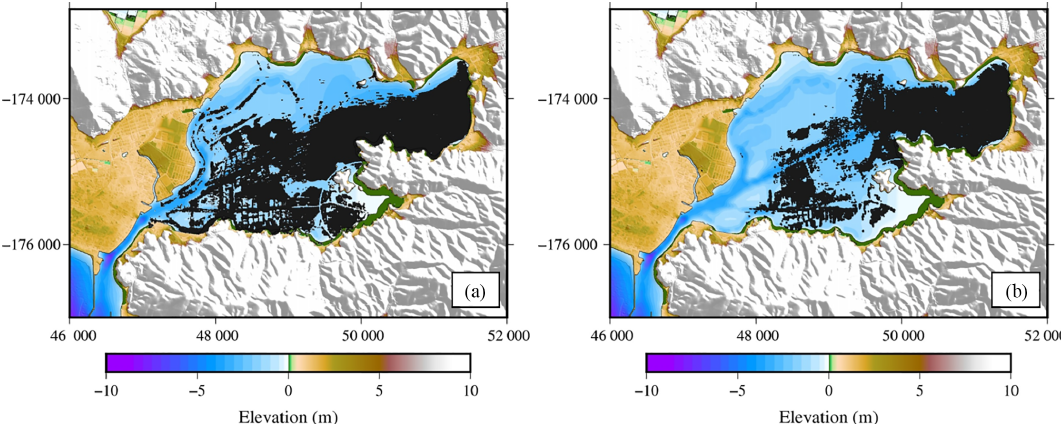
Figure 9. Areas of the eelgrass (a) before and (b) after the 2011 tsunami in Mangokuura Lake.